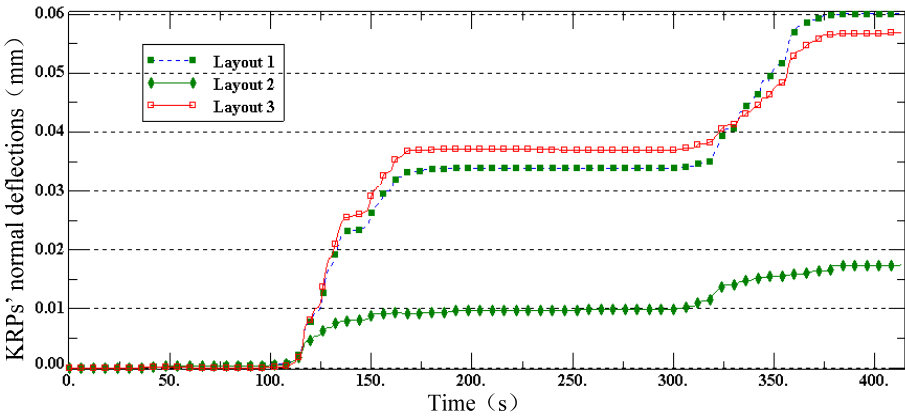
Figure 4. KRPs’ normal deflections with different fixturing layouts.